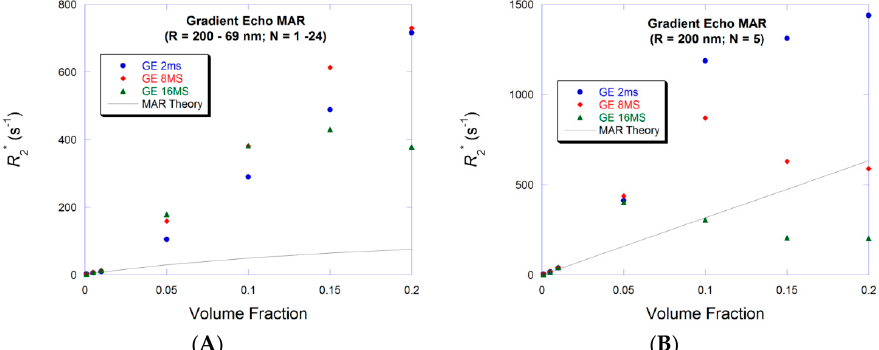
Figure 6. R 2 * values are plotted vs. particle volume fraction for particles within MAR. ( A ) The particle size is increased while the radius is decreased to achieve increasing volume fraction; ( B ) The particle size and radius are kept constant while the sample space is decreased to achieve increasing volume fraction. Particle size arrangement is important at higher particle concentrations as demonstrated by the different R 2 * values between Figure 6A,B. Furthermore, longer echo-times produce more efficient averaging of field inhomogeneities. MAR theory underestimates R 2 * simulated values.